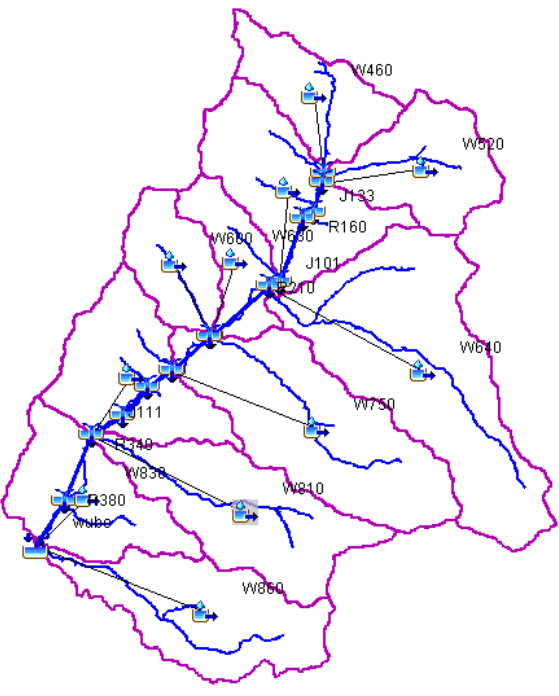
Figure 7. Generalized model of Gedong basin.